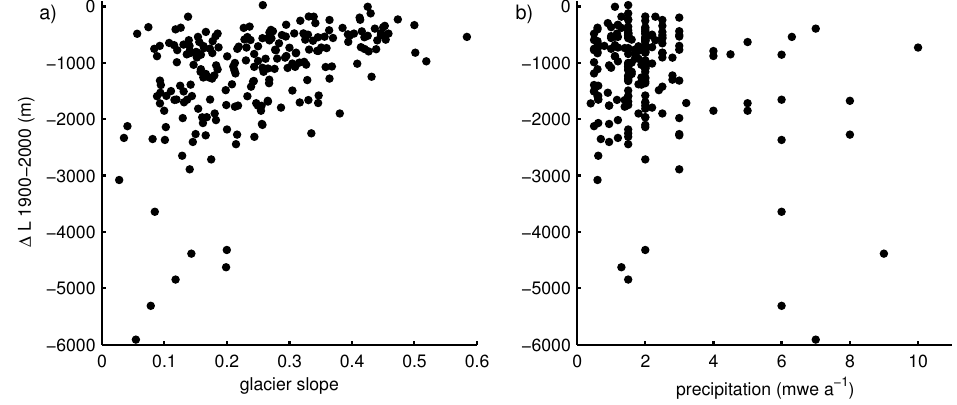
Fig. 11. Glacier length change (m) over the period 1900–2000 as a function of (a) the mean slope (h max − h min )/L 1950 of the glacier and (b) the precipitation on the glacier. The length change is only shown for the 227 records that entirely cover the period